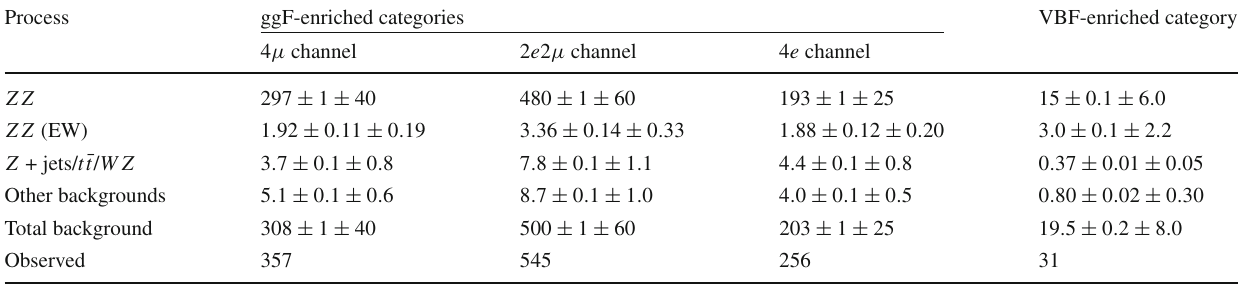
Table4 (cid:3) + (cid:3) − (cid:3) + (cid:3) − search:expectedandobservednumbersofeventsfor m 4 (cid:3) > 130GeV,togetherwiththeirstatisticalandsystematicuncertainties, for the ggF- and VBF-enriched